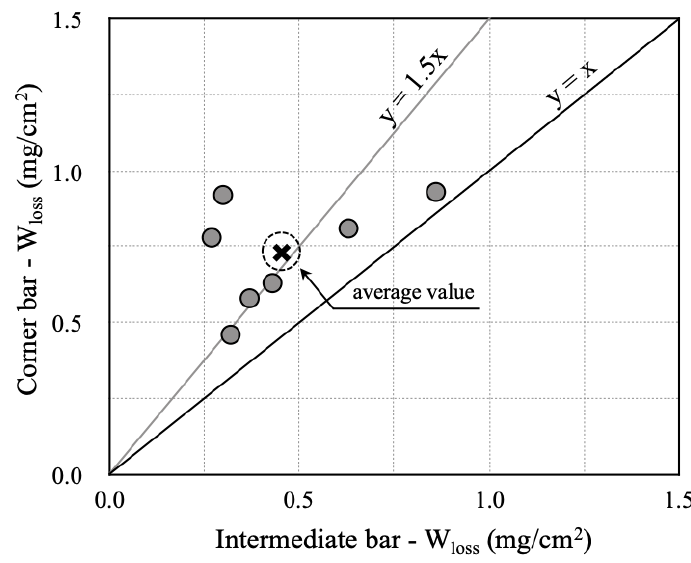
Figure 3. Comparison of weight losses between corner and intermediate bars.